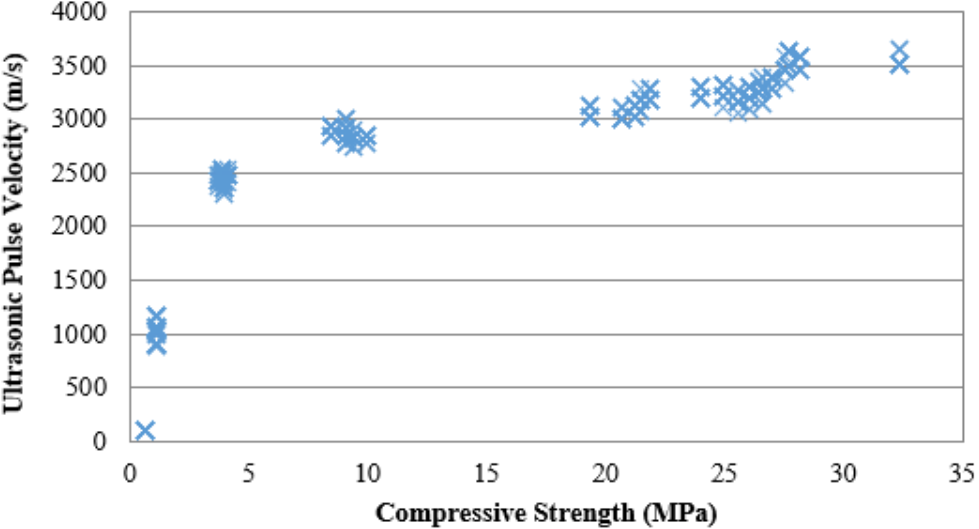
Figure 9. Relationship between ultrasonic pulse velocity and compressive strength (30 MPa).